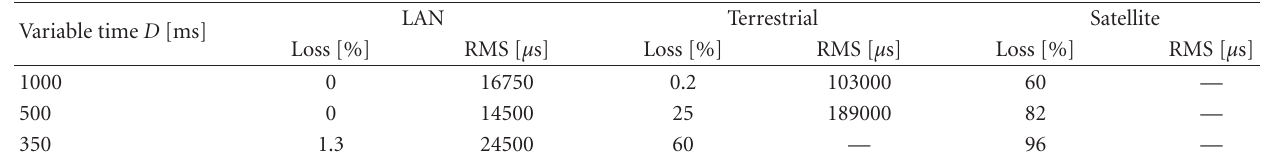
Table 2: Performance results in the presence of the DSS.